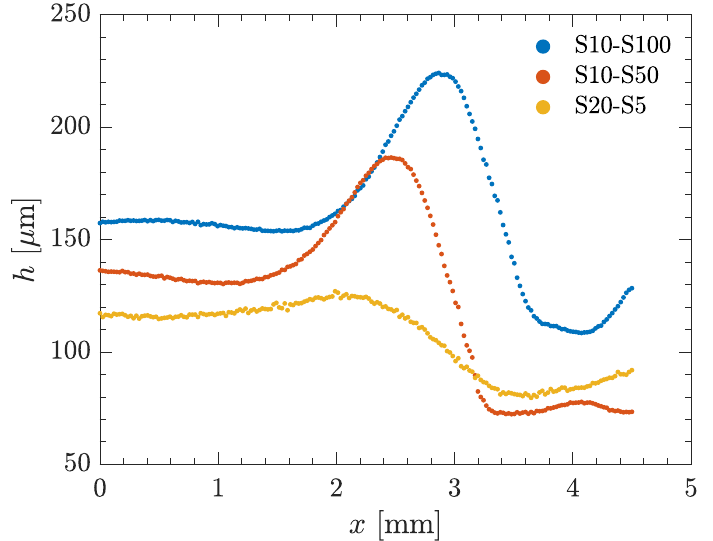
Figure 8. Lamella profile for the most extreme fluid combinations after a dimensionless time of ˜ t = 10. Impact parameters are: Blue: S10-S100, D = 2mm, U = 3.3 m/s, H f = 110 µ m, κ = 10; Orange: S10-S50, D = 2 mm, U = 3.3 m/s, H f = 73 µ m, κ = 5; Yellow: S20-S5, D = 2 mm, U = 3.3 m/s, H f = 60 µ m, κ = 0.25. The fluid combinations used are expressed by the acronym Sxx-Syy, where Sxx denotes the drop and Syy denotes the film